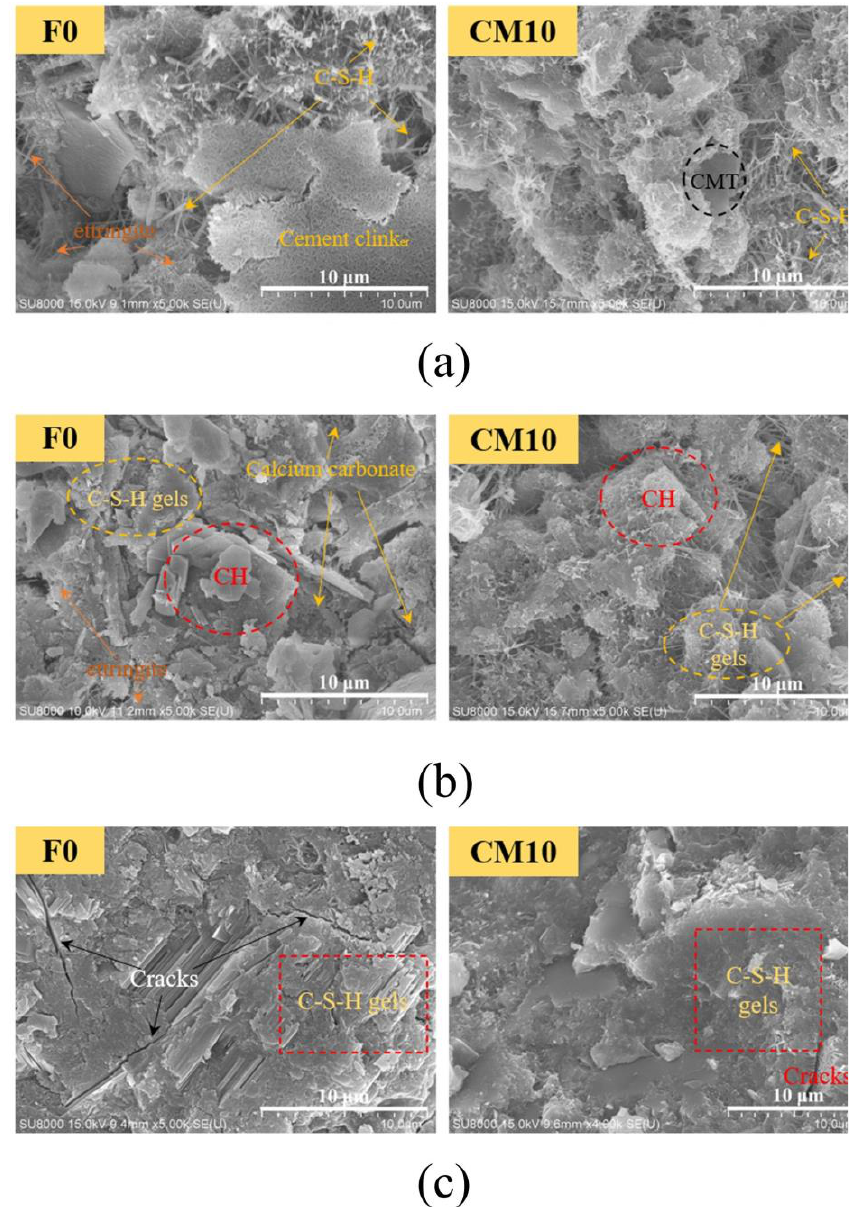
Figure 9. Micromorphology of cement paste at different ages before and after adding calcined montmorillonite: ( a ) 3 d; ( b ) 7 d; ( c ) 28 d.